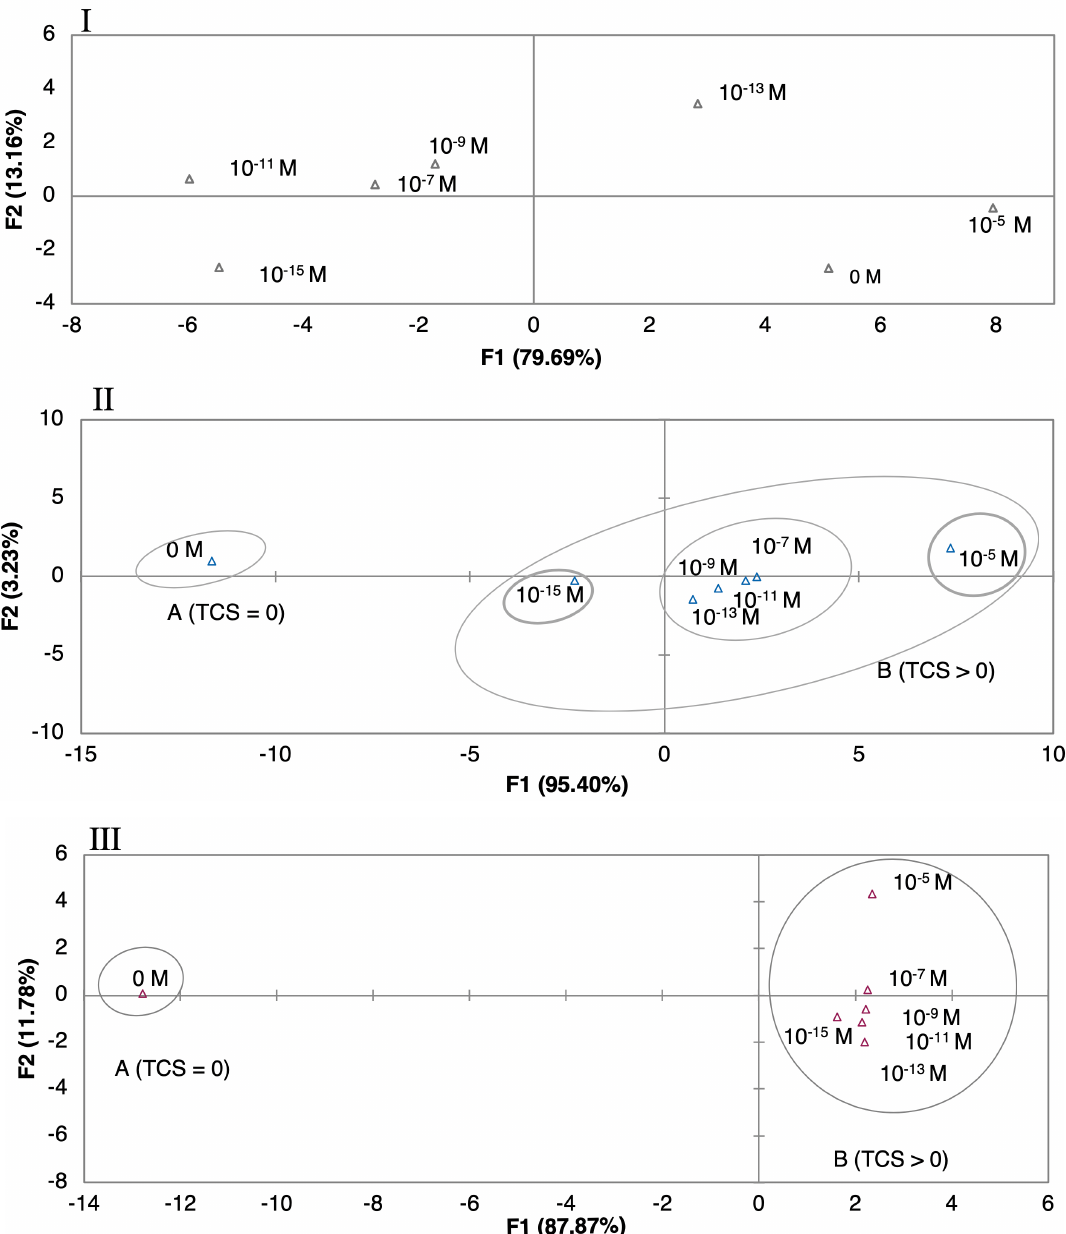
Figure 4. PCA plots of TCS concentrations (10 − 5 –10 − 15 M) distinguished by ( I ) the (PAH / GO) 5 sensor for DW, ( II ) the gold IDE sensor for MW, and ( III ) the (PEI / PSS) 5 sensor for EF.